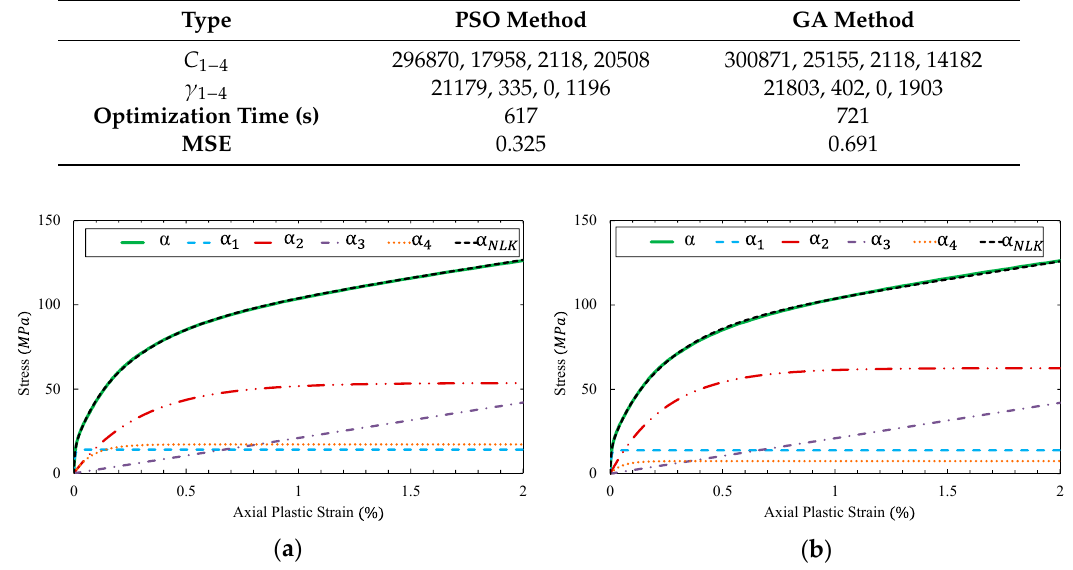
Table 3. PSO and GA calibration for post-stabilized monotonic curve with elastic limit 244 MPa.